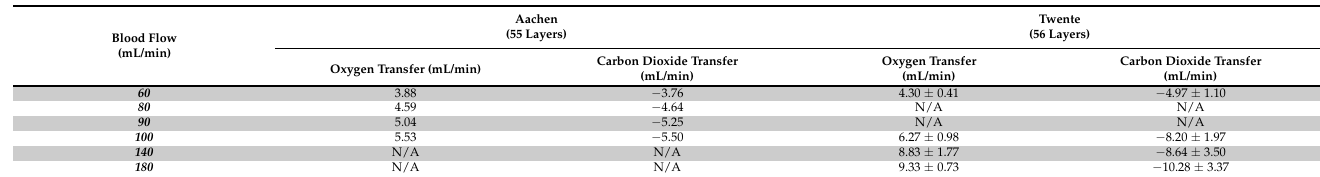
Table 4. Oxygen and carbon dioxide transfer rates over blood flow for n = 1 experiments with 55-layer oxygenators conducted at the University Hospital Aachen and n = 10 experiments with 56 fiber layer oxygenators conducted at the Twente